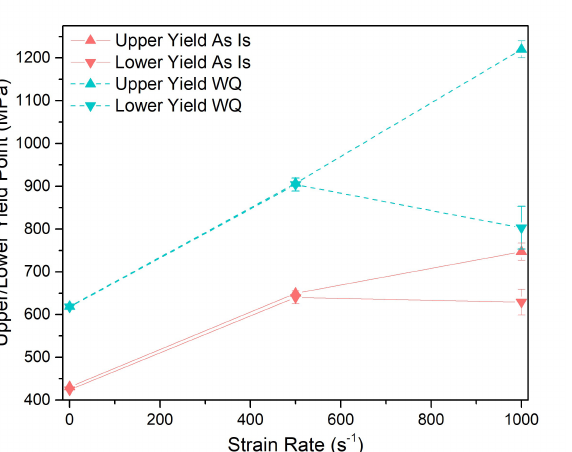
Figure 8. Upper and lower yield stress over the considered strain-rates, both for the quenched and the as-is Fe